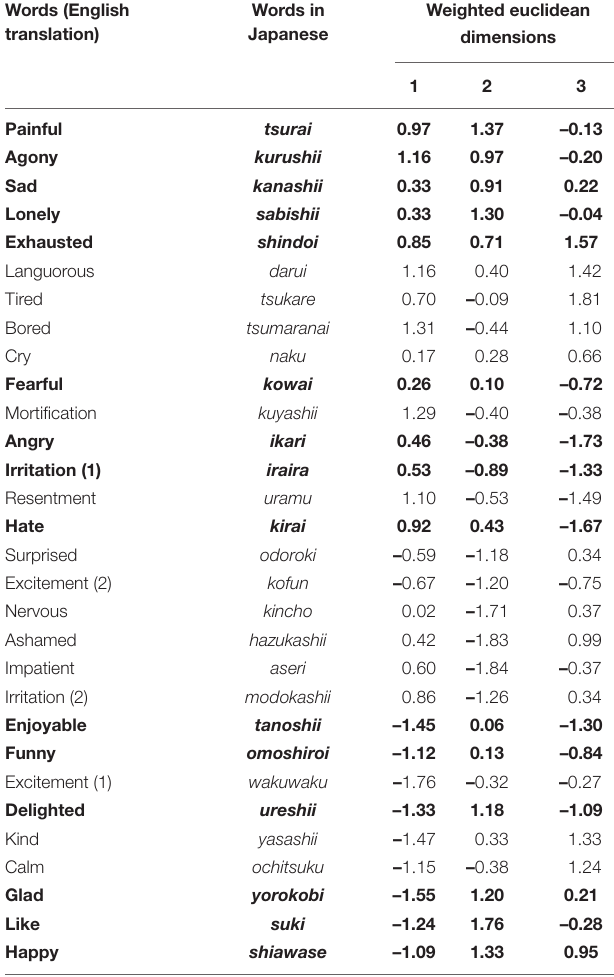
TABLE 1 | MDS scores of emotion words in